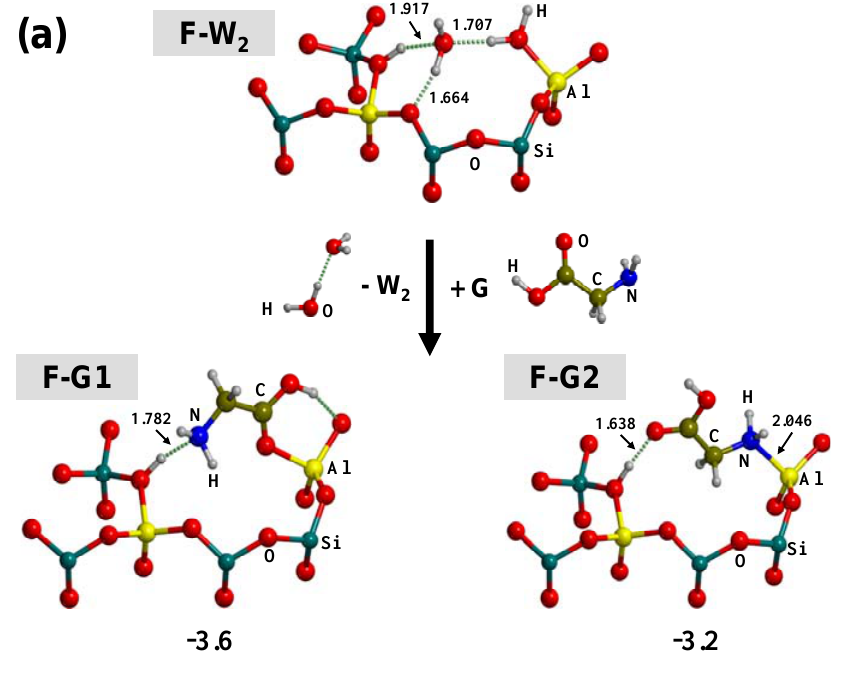
Figure 2. (a) ONIOM2-optimized geometries of the sanidine feldspar structure in O molecules ( F-W2 ) or one glycine molecule ( F-G1 and F- interaction with either two H 2 G2 ). Reaction free energies, Δ G +D (kcal mol -1 ), for the water displacement by glycine 298 as bare numbers. (b) ONIOM2-optimized geometry of the sanidine feldspar structure in interaction with glycine in a form activated towards nucleophilic attack by an incoming glycine (see text for further details). Only the high level zone is shown for brevity. Distances in